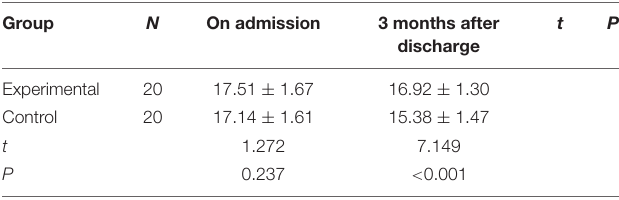
TABLE 4 | Comparison of medication compliance scores between the two groups of IBD patients at admission and 3 months after discharge (x ± s). Group N